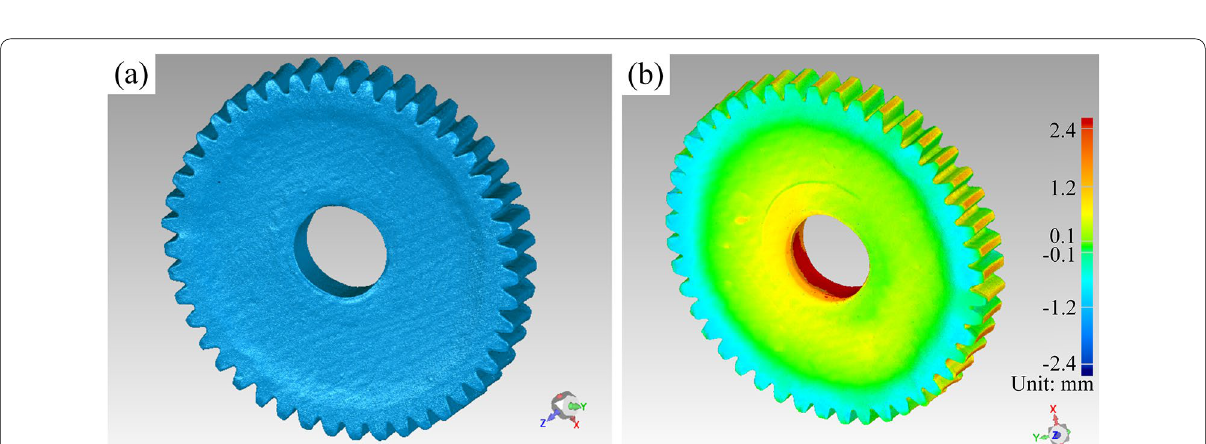
Figure 15 The sample after finishing stage: (a) 3D solid model and (b) dimensional deviation